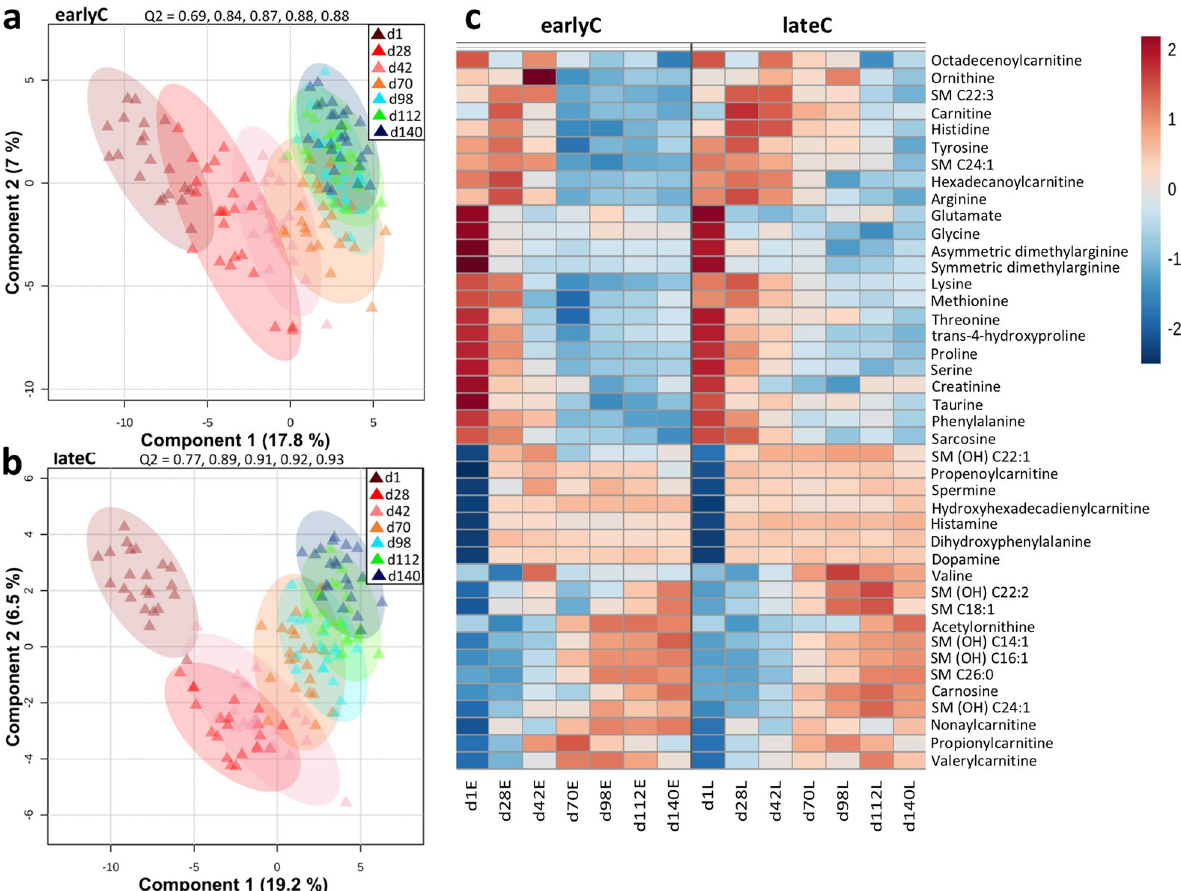
Fig. 4 Age‑dependent changes in plasma metabolites concentrations of earlyC and lateC calves. a , b Metabolic profiles of different age group earlyC ( n 174) and lateC ( n 153) plasma samples visualized using PLS‑DA score plots. Each shape indicates one sample coloured according to = = the age group with ellipse indicating the 95% confidence region. c Heatmap of the significantly altered metabolites due to calves age (VIP > 1, FDR < 0.001, ANOVA). Each day represents an average concentration of metabolites for animals: d1 (20 & 22), d28 (24 & 21), d42 (24 & 23), d70 (25 & 21), d98 (27 & 21), d112 (27 & 23), and d140 (27 & 22) animals for earlyC and lateC groups,